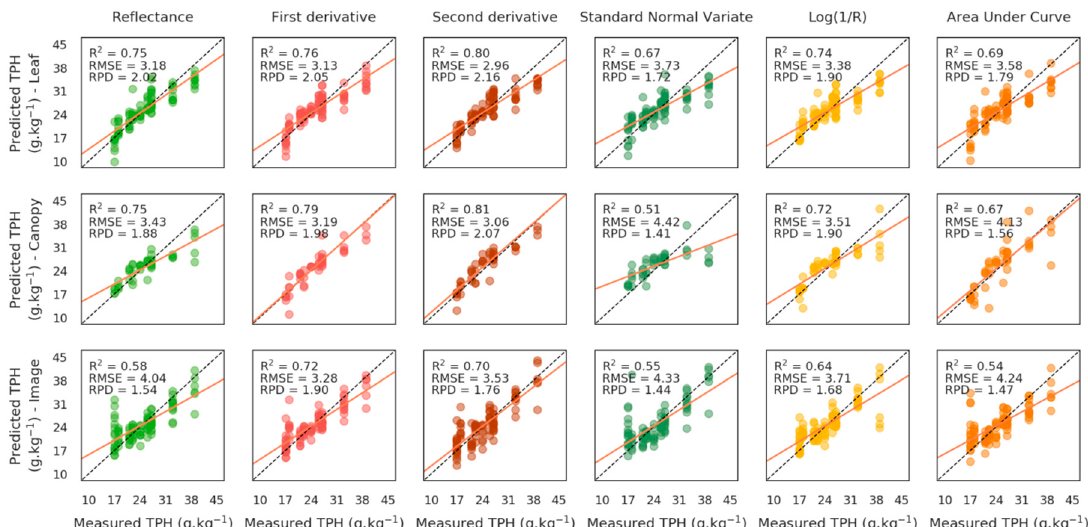
Figure 4. Comparison between measured and predicted TPH concentrations on the test set on the 10 plots of the brownfield using the elastic net regression on the original and transformed spectral signatures (in columns). First, second, and third rows show the results obtained at leaf and canopy scales and on the airborne image, respectively.